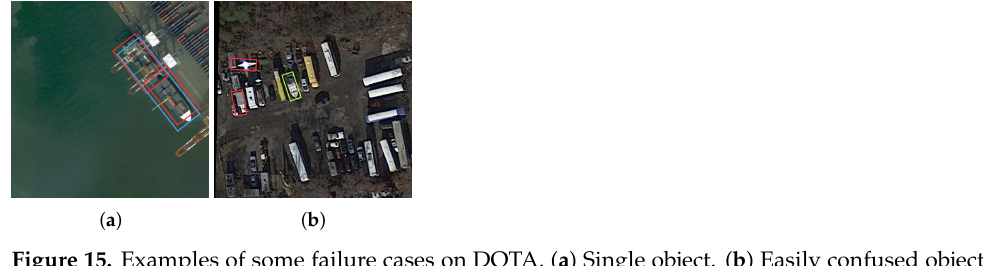
Figure 15. Examples of some failure cases on DOTA. ( a ) Single object. ( b ) Easily confused objects on